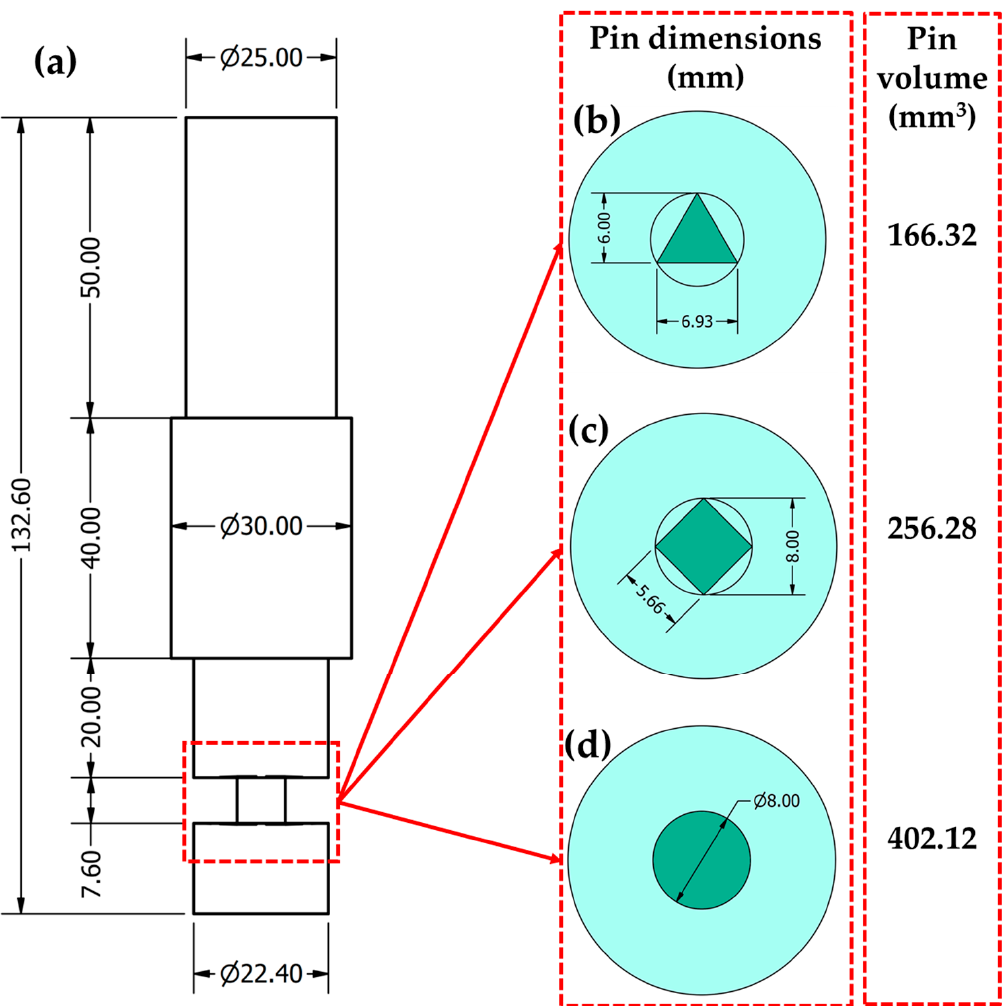
Figure 3. ( a ) Dimensions and volumes of the BT (all dimensions in mm) and the BT pin profiles; ( b ) Tr, ( c ) Sq, and ( d ) Cy.